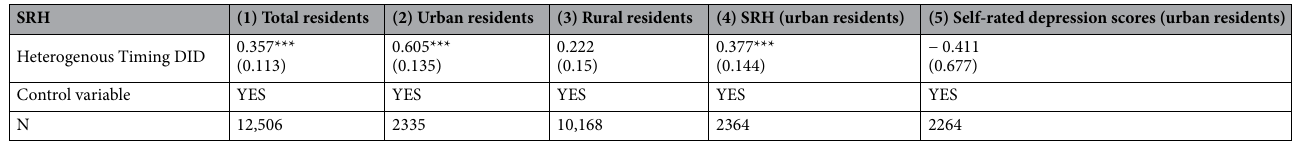
Table 3. Health effects of LTCI on older residents. * p < 0.10, ** p < 0.05, *** p <